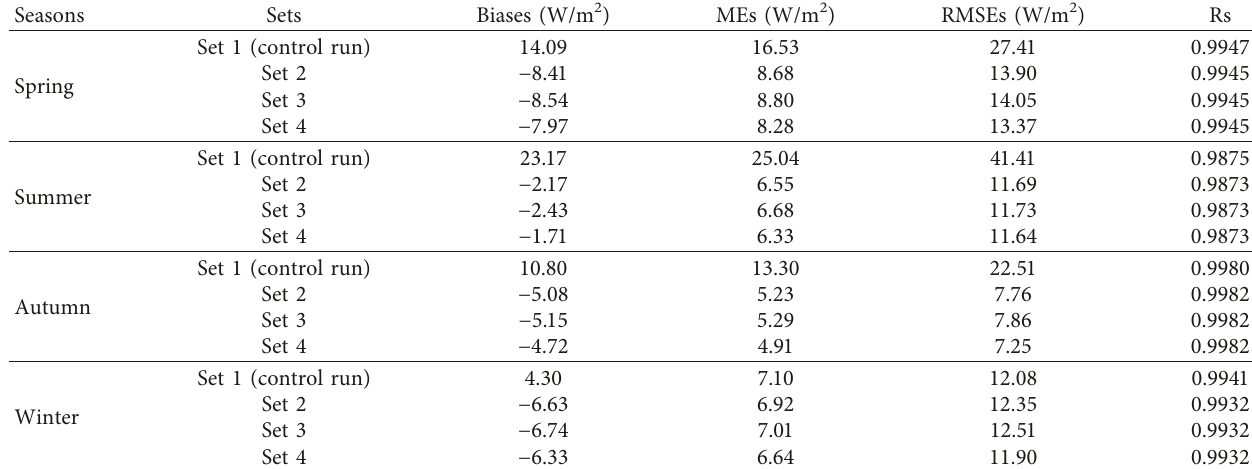
Table 3: Biases, mean errors (MEs), root mean square errors (RMSEs), and correlation coefficients (Rs) of the upward solar radiation simulated by the four sets of experiments compared with those of the observations for each season. Seasons Sets Biases (W/m 2 ) Spring Set 1 (control Summer